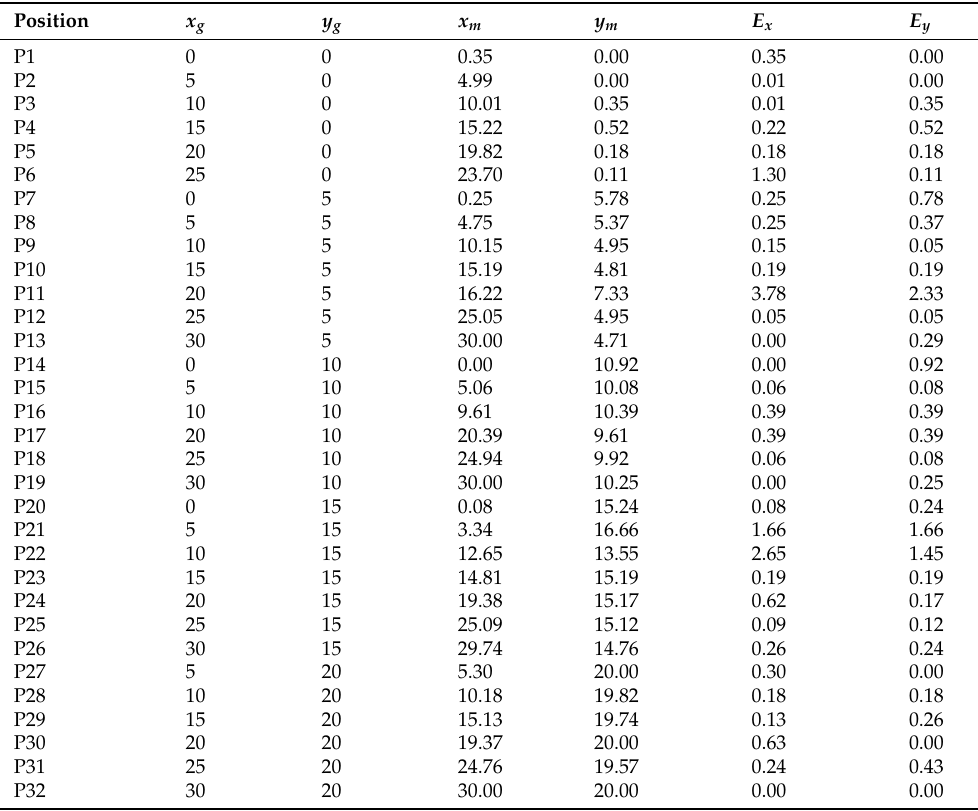
Table 10 presents the position estimation results. The mean error values of E x and E y were, respectively, 0.46 m and 0.38 m. The error value at P11 was the highest. Moreover, the error values at P6, P21, and P22 were high. These positions were present in the shallow angles. For this setup of the microphone frontal directions, slight angular errors induced greater coordinate errors. Table 10. Position estimation results obtained from Experiment C